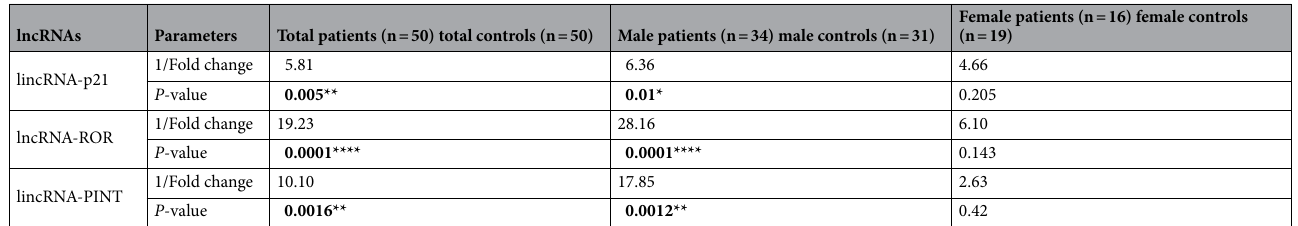
Table 3. Relative expression of lncRNAs in BD patients and healthy controls. *significant p -value < 0.05, **significant p -value < 0.01, ****significant p -value < 0.0001.